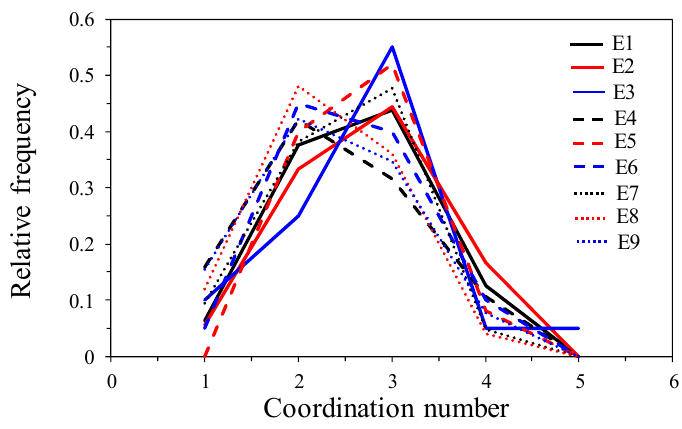
Figure 2. Relative frequency of the coordination number in the random samples E i ( i = 1, ..., 9). Table 2. Topological and morphological information of the elementary cells: total number of pores, N pores ; average coordination number, (cid:104) Cn (cid:105) ; ratio (cid:104) Cn (cid:105) / N pores ; area of the solid phase, M 0 ; boundary length between solid and fluid, M 1 ; and Euler number, M 2 .